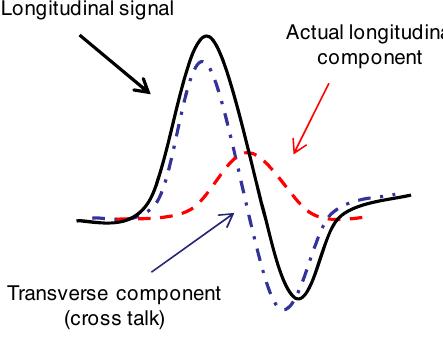
FIG. 2. Schematic feature of SQUID signals before and after deconvolution.